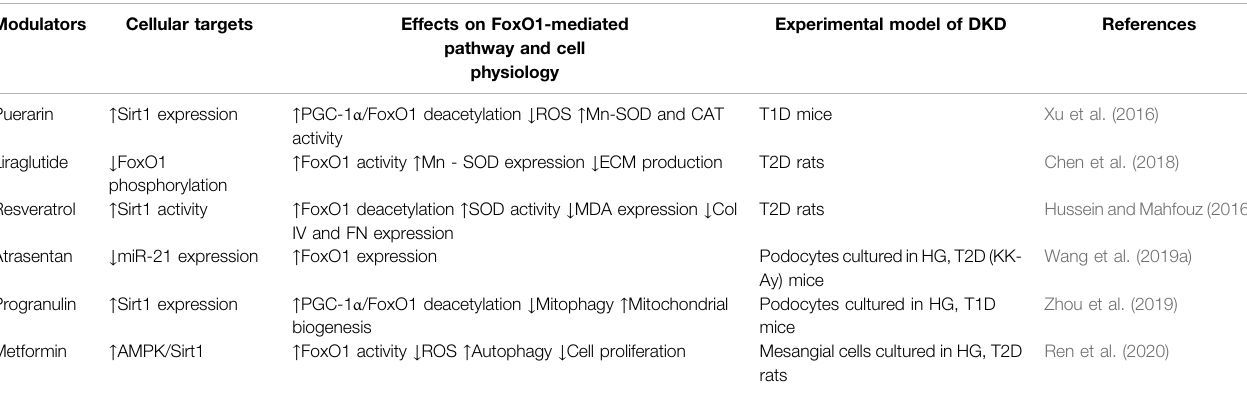
TABLE 1 | Potential FoxO1 modulators and their effects in